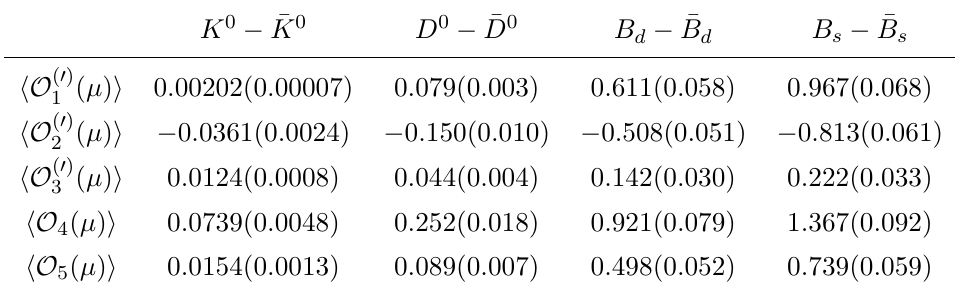
Table 4 . Values for the matrix elements of ∆ F = 2 operators, in units of GeV 4 . The renormalization scale is µ = { 3 , 3 , 4 . 18 , 4 . 18 } GeV for P = { K, D, B d , B s }